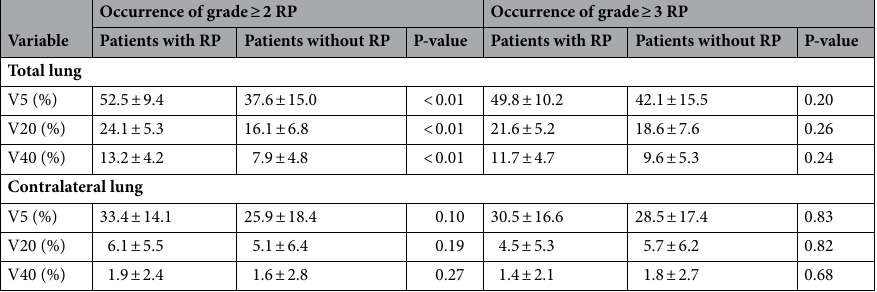
Table 4. Comparison of dosimetric values of patients with and without radiation pneumonitis. RP radiation pneumonitis, V5 lung volume receiving a dose of ≥ 5 Gy, V20 lung volume receiving a dose of ≥ 20 Gy, V40 lung volume receiving a dose of ≥ 40